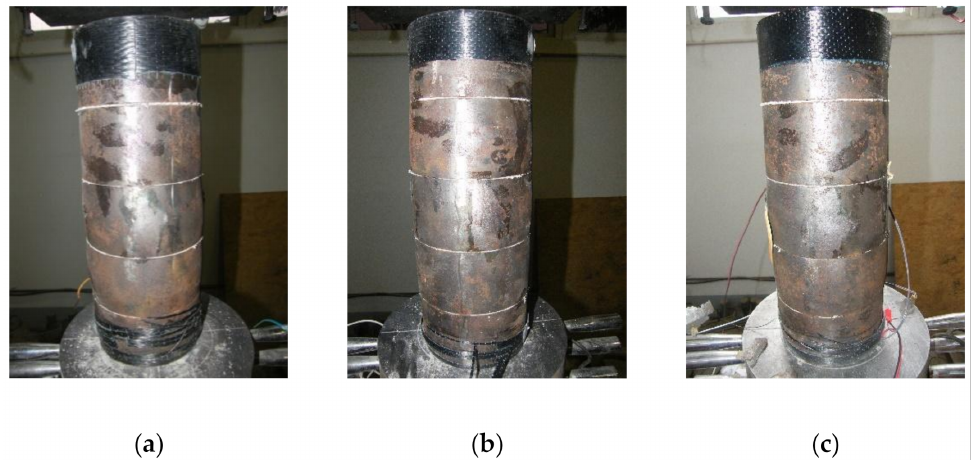
Figure A2. Failure modes of the CFGT columns. ( a ) S4.5N ( b ) S6N ( c ) S7.5N.